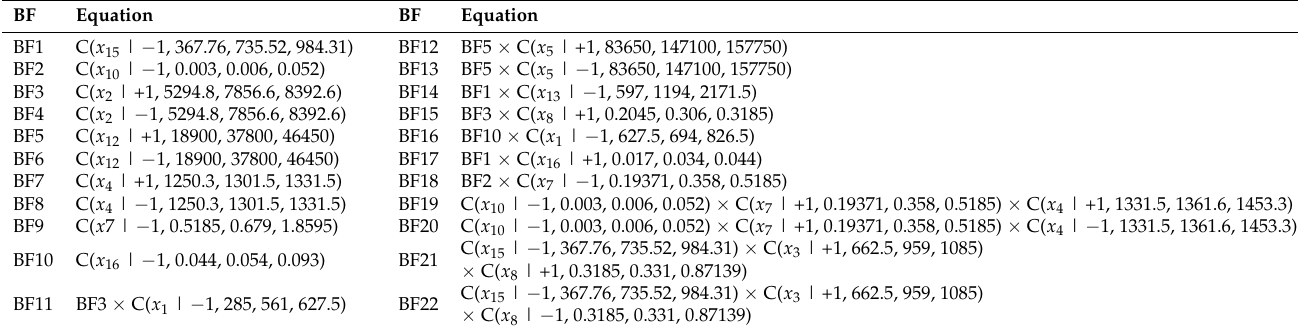
Table 8. Basis functions of the piecewise-cubic MARS model of melt